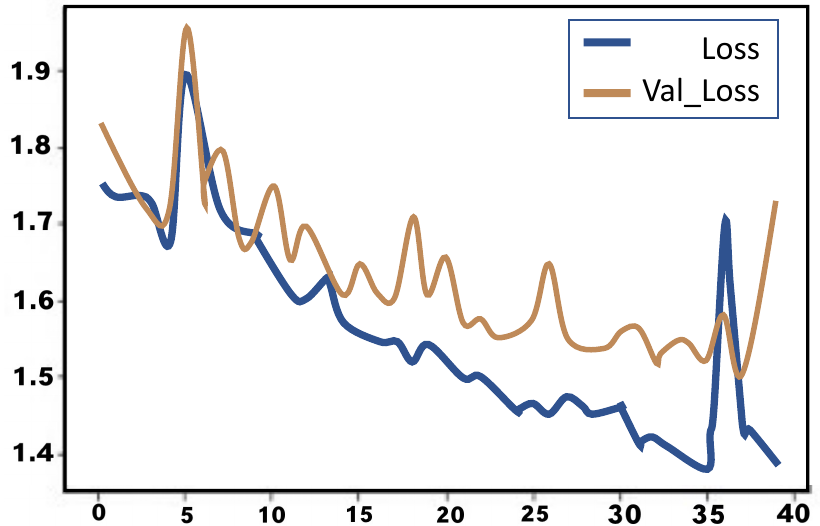
Figure 18. Graph of loss against the number of epochs in training and testing of the LSTM